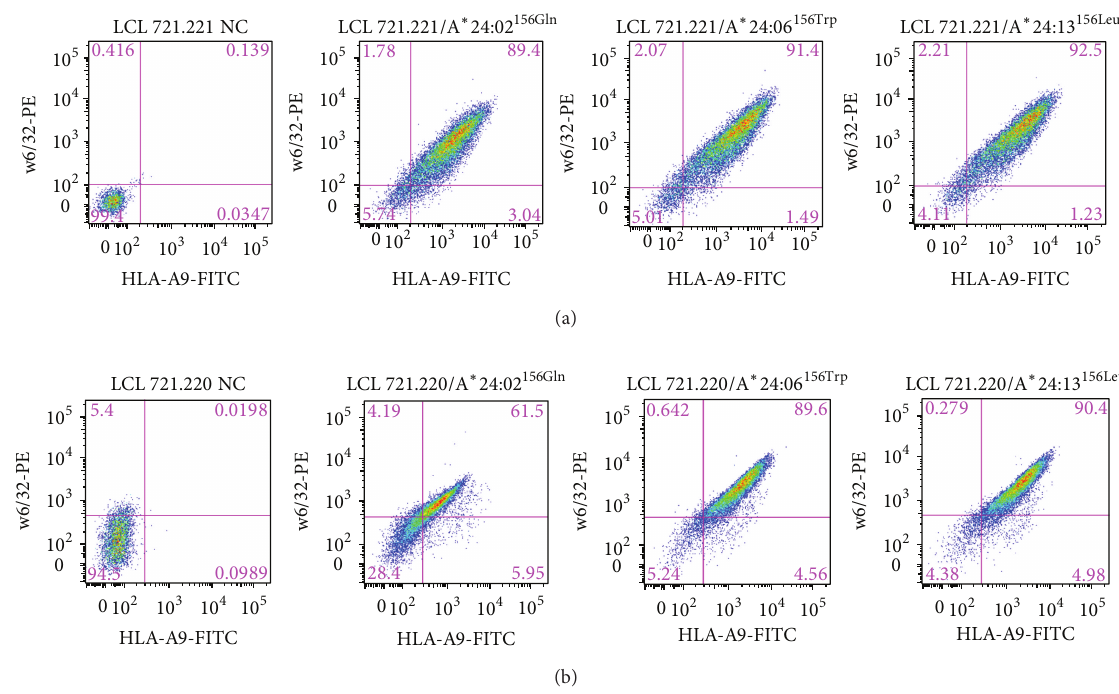
Figure 1: HLA-A ∗ 24/156 variants are expressed at different levels on the surface 721.220 (HLA-/TPN − ) or 721.221 (HLA-/TPN+) cells. Flow cytometric analysis of HLA-A ∗ 24/220 and HLA-A ∗ 24/221 cells stained with anti-HLA-A9-FITC and w6/32-PE conjugated mAbs. Figures 1(a) and 1(b) show expression of HLA-A ∗ 24/156 variants on the surface of 721.221 and 721.220 cells, respectively. All the three allelic variants, HLA- A ∗ 24:0 2 156 Gln , HLA-A ∗ 24:0 6 156 Trp , and HLA-A ∗ 24:1 3 156 Leu , showed high levels ( ∼ 92%) of expression on the surface of 721.221 cells. In 721.220 cells, HLA-A ∗ 24:0 6 156 Trp and A ∗ 24:1 3 156 Leu were expressed at relatively higher levels ( ∼ 90%) as compared to HLA-A ∗ 24:0 2 156 Gln ( ∼ 60%).